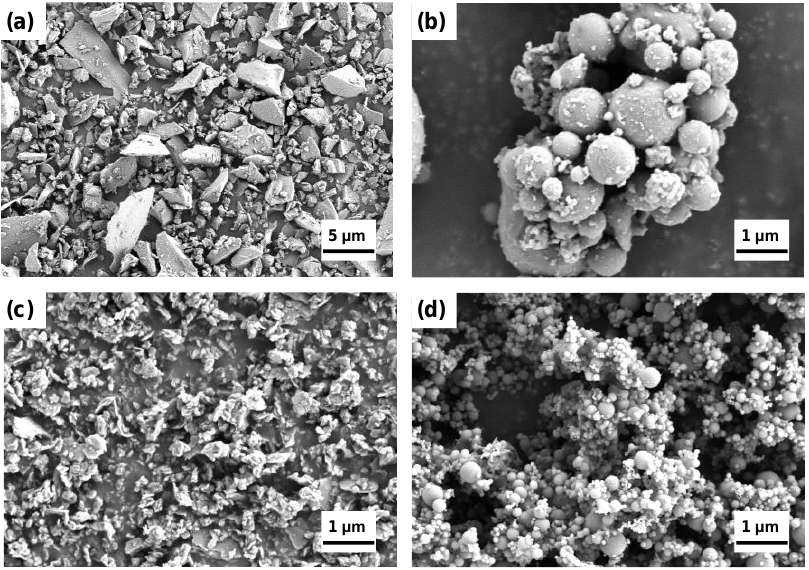
Figure 3. SEM micrographs of ( a ) GGBS; ( b ) FA; ( c ) MK; and ( d ) SF.